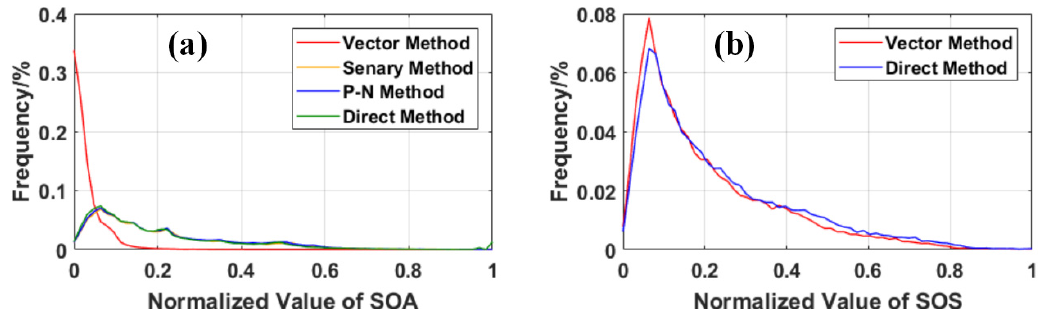
Figure 6. Frequency distribution using di ff erent methods on the Gaussian surface. Curves of ( a ) SoA and ( b ) SoS.